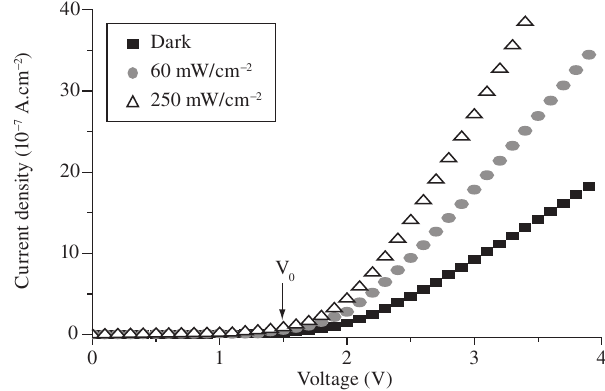
Figure 2. Current density vs. voltage (J vs. V) curves of ITO/MH-PPV/Al structure performed in vacuum and under different illumination conditions (dark, 60 mW.cm –2 and 250 mW.cm –2 ).